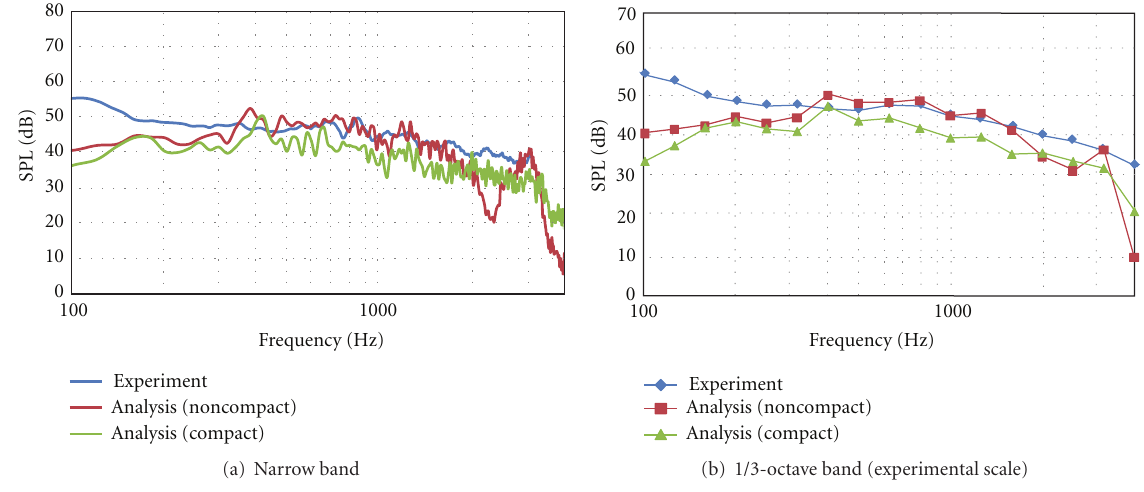
Figure 10: Comparison of SPL spectrum by experiment and computations.